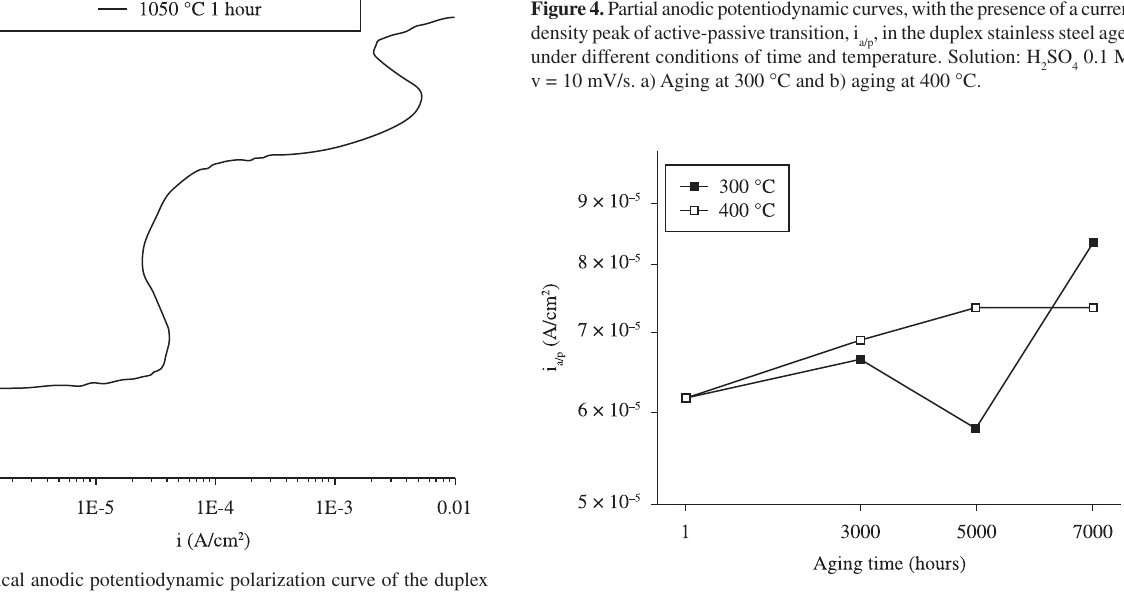
Figure 5. Critical current density at the peak as a function of aging time and SO 0.1 M, 2 4 temperature in duplex stainless steel alloy in 0.1 M H